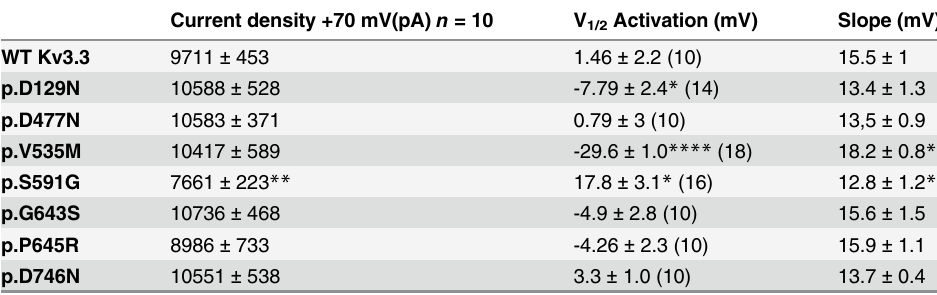
Table 2. Overview of Kv3.3 channel